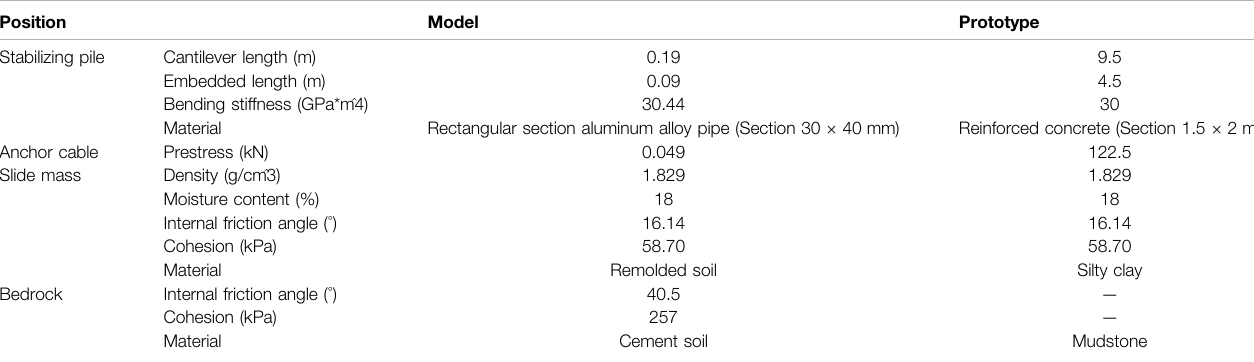
TABLE 2 | Model material parameters.